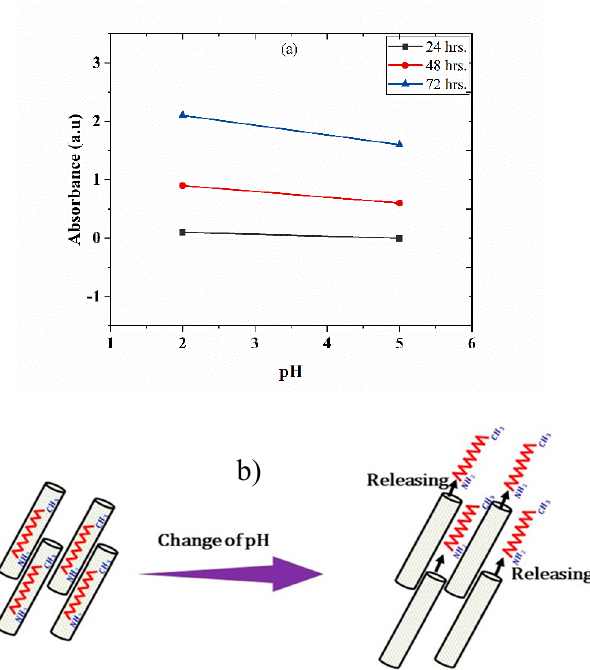
Figure 6. ( a ) UV spectra of TNTs encapsulated with DOC immersed in 0.1M NaCl solution at pH 2 and pH 5 and ( b ) schematic diagram showing the self-release of DOC from TNTs in response to pH change.